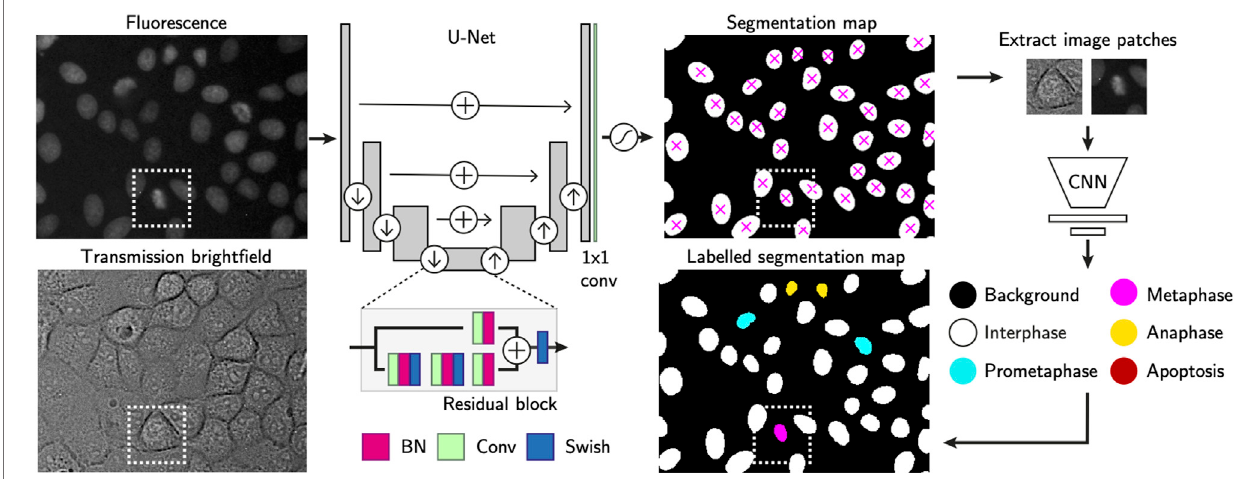
FIGURE 2 | Single-cell annotation work fl ow. Cell instances are segmented from fl uorescence images of their H2B-GFP labelled nuclei. The U-Net consists of residual blocks and residual skip connections. A fi nal 1 × 1 convolution layer, followed by softmax activation generates the output. Detected cells are localised using the centre of mass and used to crop nucleus-centred image patches from both transmission and fl uorescence images. These serve as inputs to a CNN-based cell state classi fi er to label instantaneous phase of each segmented object. Labels indicate whether the cell is in interphase, mitosis or apoptosis. Scale bars (cid:1) 20